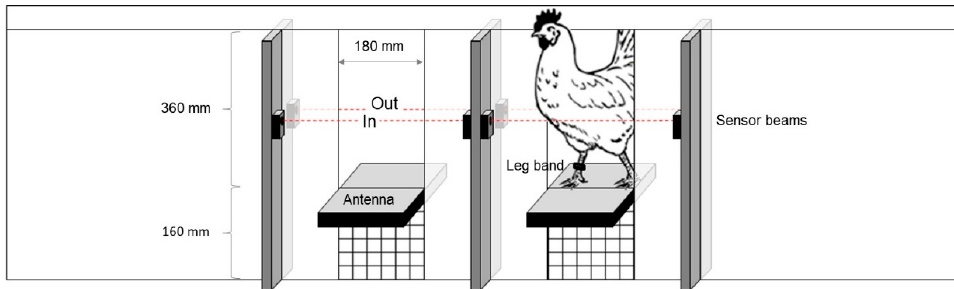
Figure 2. The radio-frequency identification system placed within the pop-holes of each pen. Two passageways allowed the movement of a single bird each across an antenna. Two sets of sensor beams allowed the determination of movement direction, ‘out’ to the range, or back ‘in’.